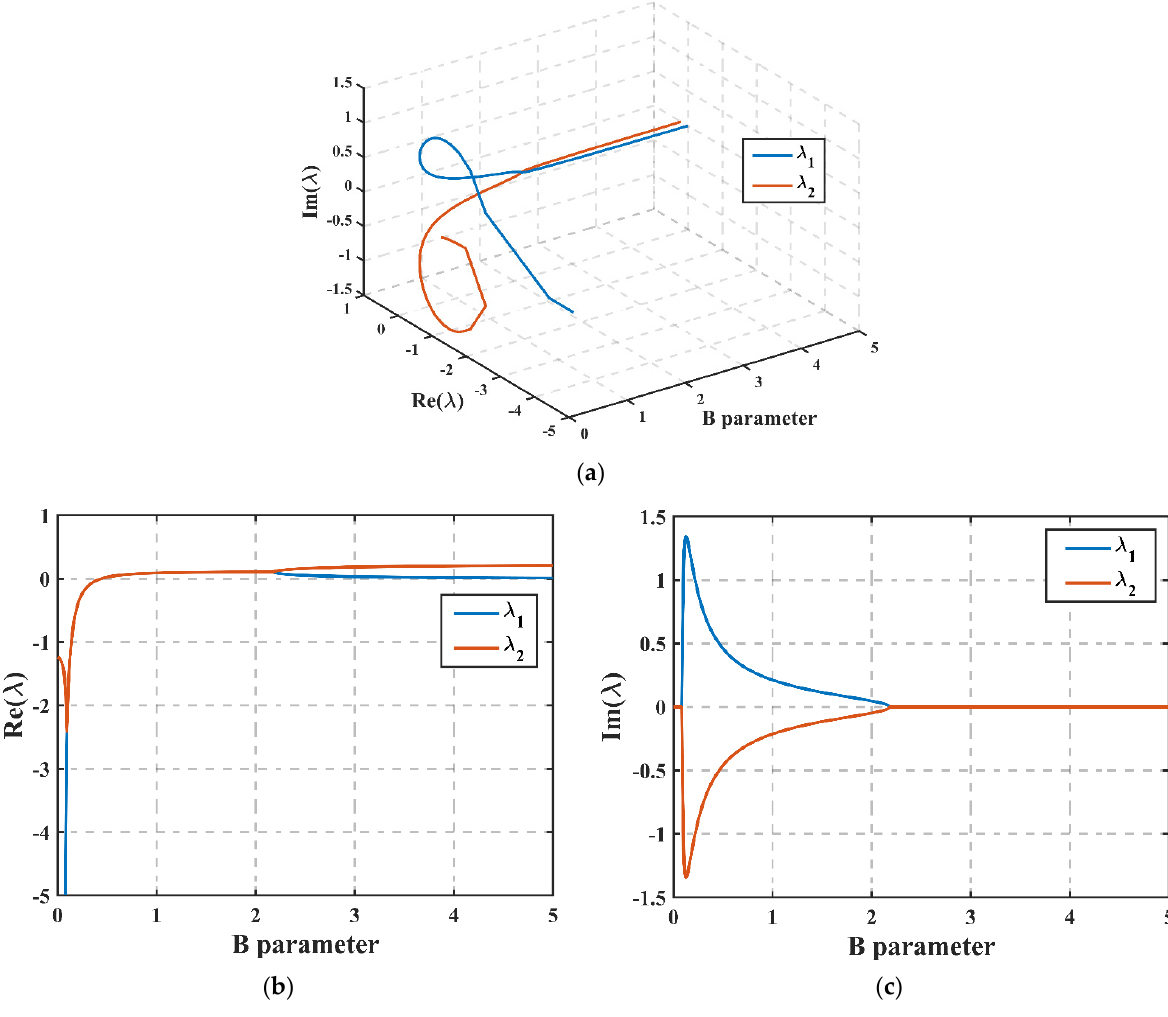
Figure 4. The Variation of eigenvalue trajectories with B parameter: ( a ) Variation of two eigenvalues; ( b ) Variation of real part of two eigenvalues; ( c ) Variation of imaginary part of two eigenvalues.